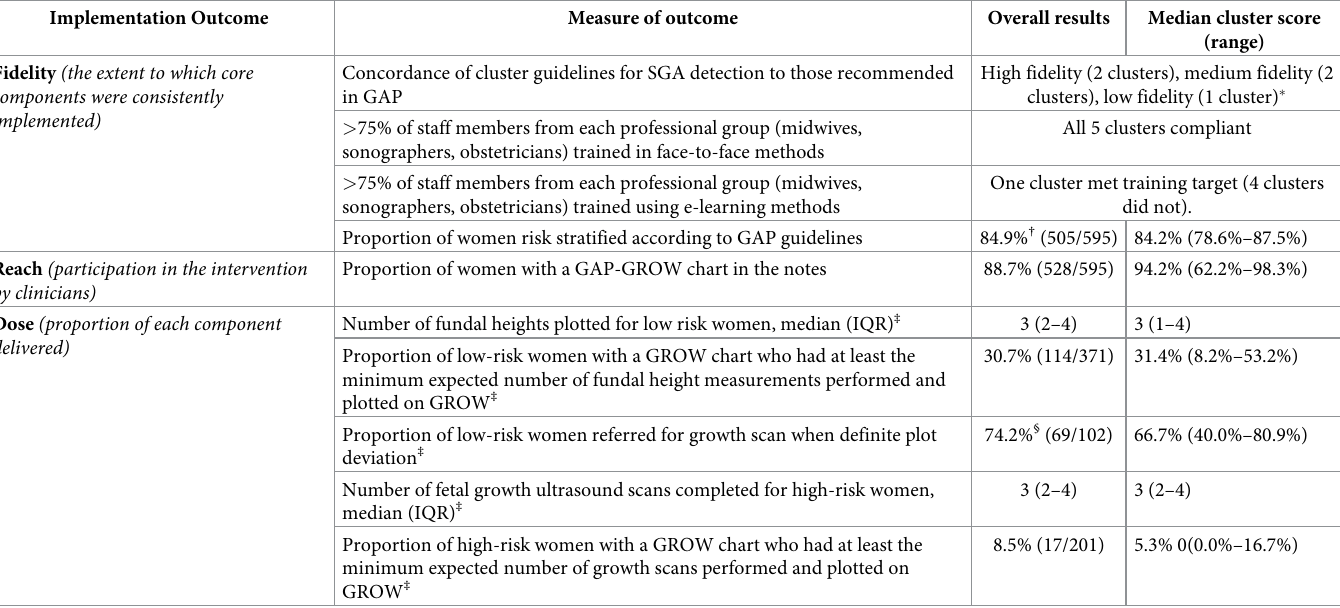
levels of fidelity (high rates of face-to-face training, varied concordance of cluster site guide- lines with GAP, high concordance with GAP risk stratification protocols), high levels of reach (majority of women had a GROW chart), but variable dose (low number of fundal height mea- surements plotted, number of growth scans below that which is recommended by GAP, high rates of referral for suspected SGA). Table 7. Assessment of implementation strength: reach, dose, and